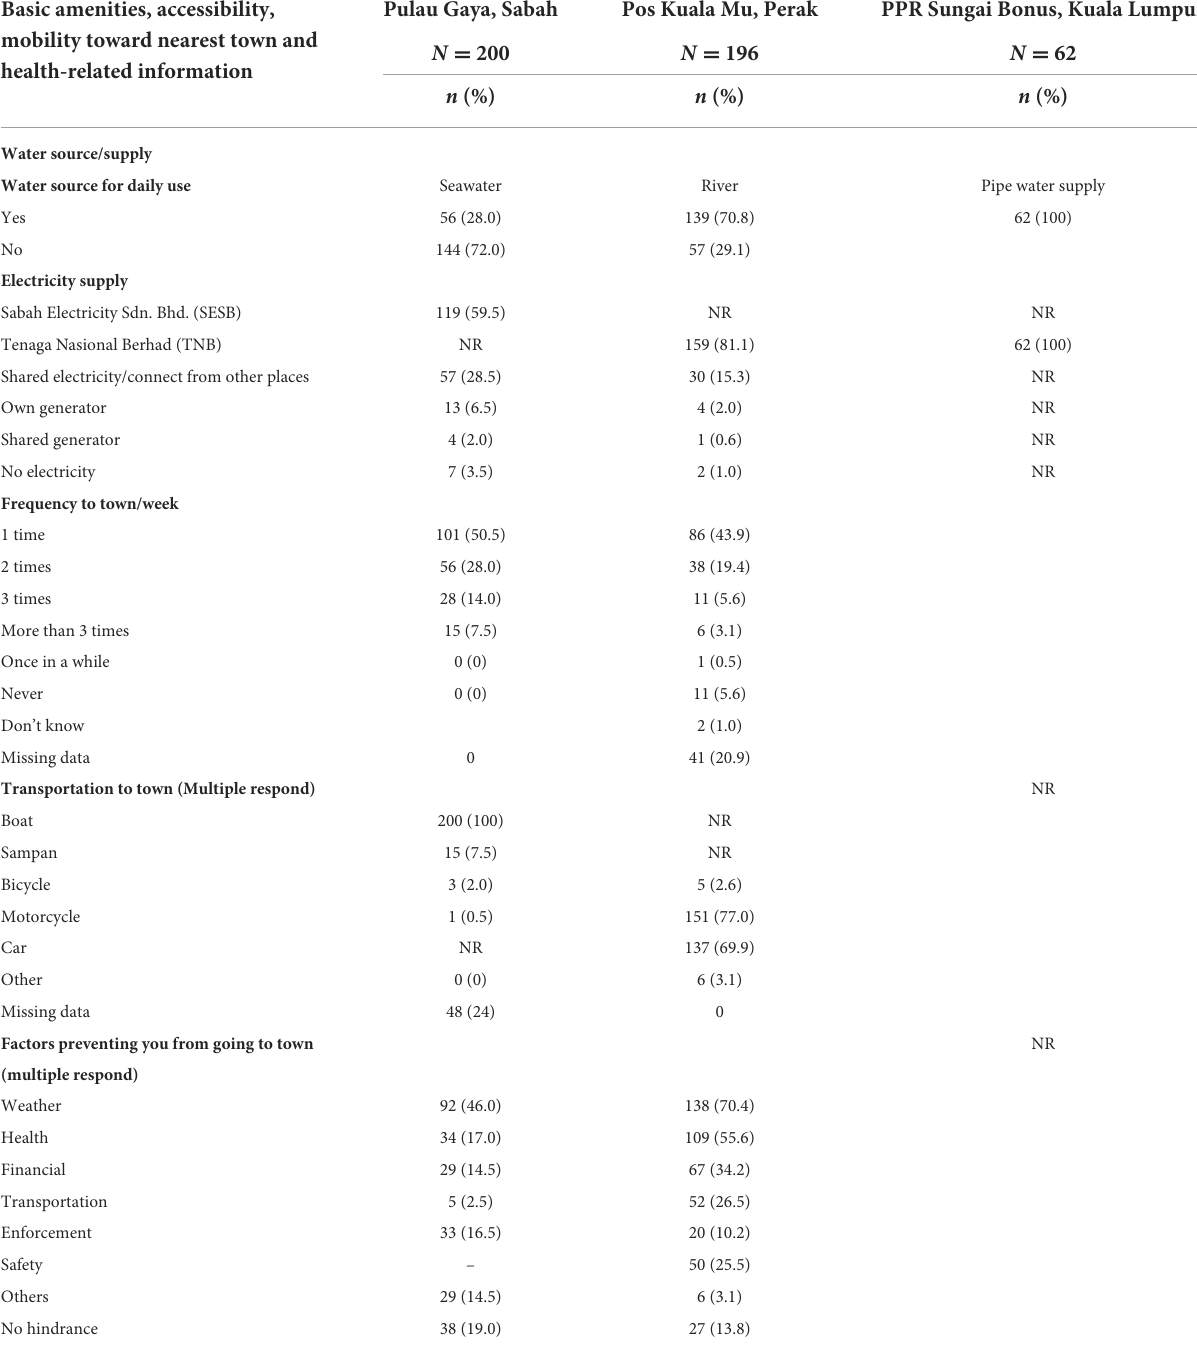
TABLE 5 Participants basic amenities, accessibility, mobility to town and health-related information. Basic amenities,